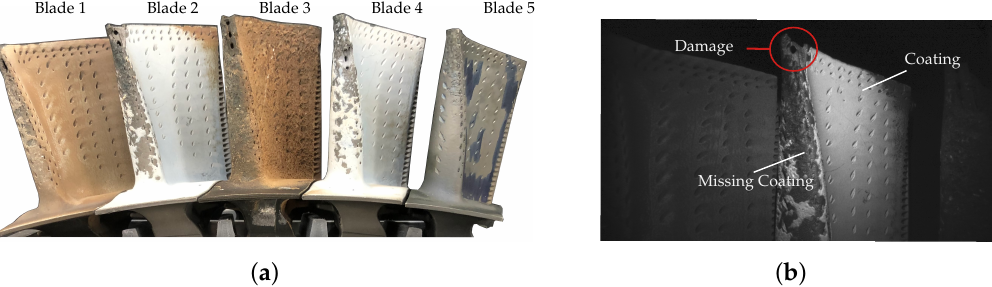
Figure 2. Turbine blades with different levels of wear and damages and a camera view of an exemplary inspection pose. ( a ) Blade setup for borescopic measurements. ( b ) Camera view of an exemplary measurement